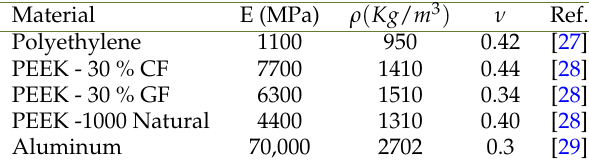
Fig. 2. FG rectangular Sandwich plate (a) schematic diagram, (b) Even porosity distribution of across core thickness Table 1. Material properties of the FGM sandwich